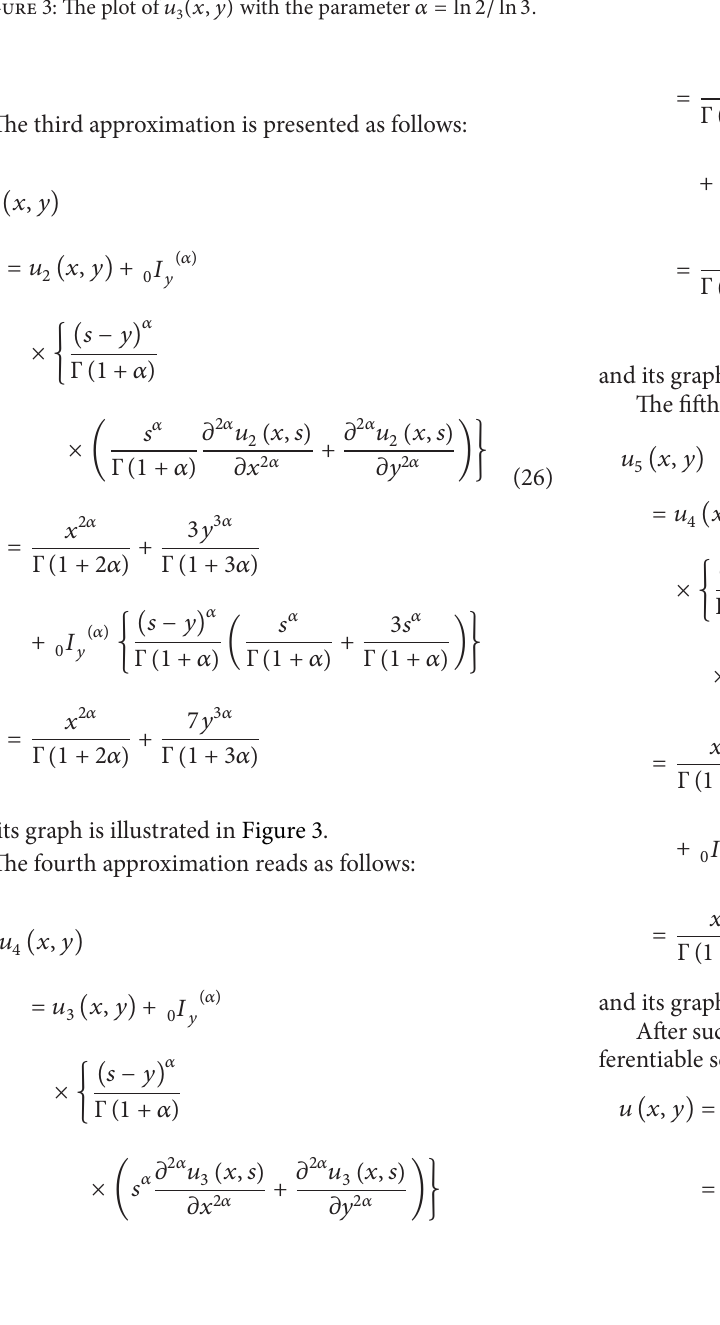
Figure 4: The plot of 𝑢 4 (𝑥,𝑦) with the parameter 𝛼 = ln 2/ ln 3